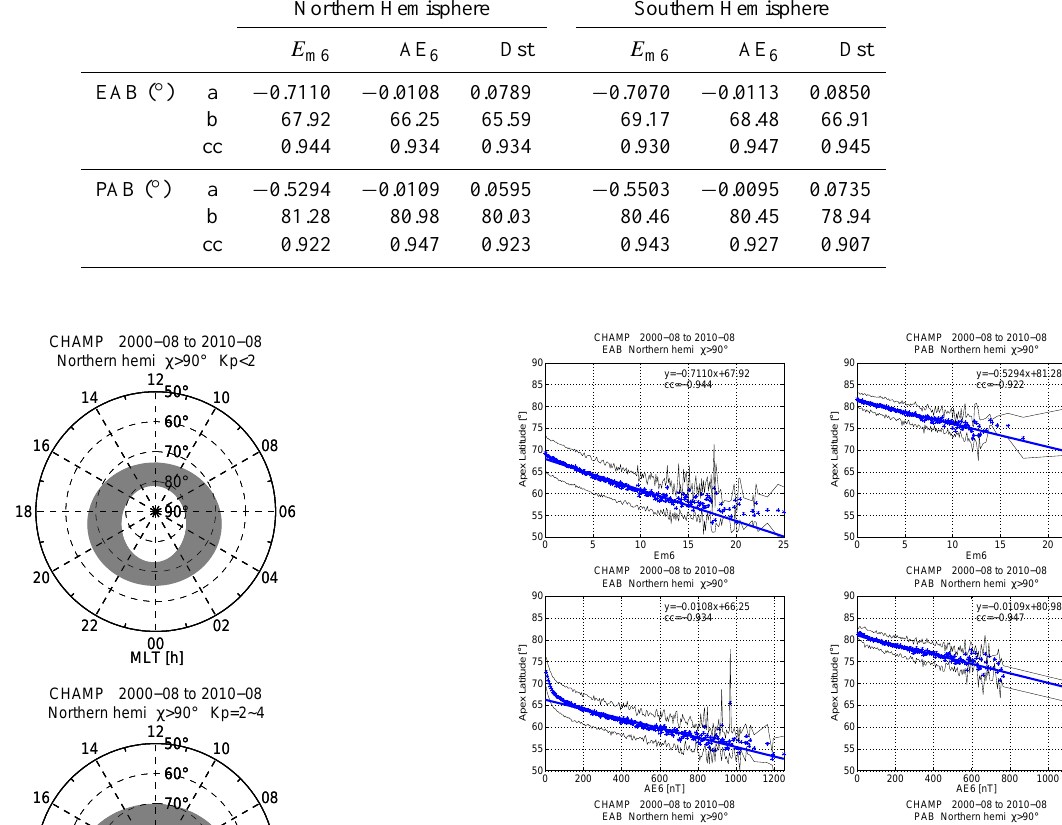
Table 2. Linear fit parameters and correlation coefficients between the apex latitudes of the auroral oval boundaries and various indices. Northern Hemisphere